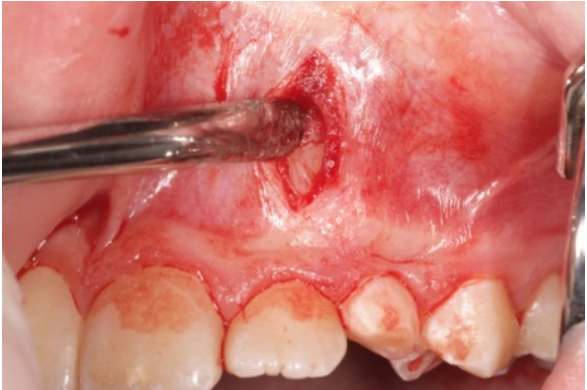
Figure 3. Exposure of the canine crown through a vertical incision.